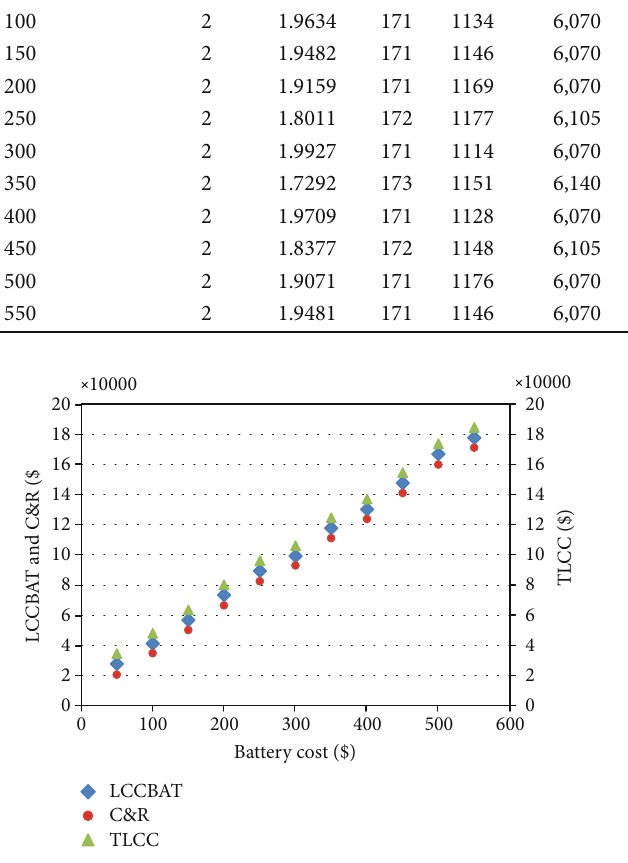
Figure 11: TLCC, LCC BAT , and C&R of the hybrid system vs. battery cost in the optimal